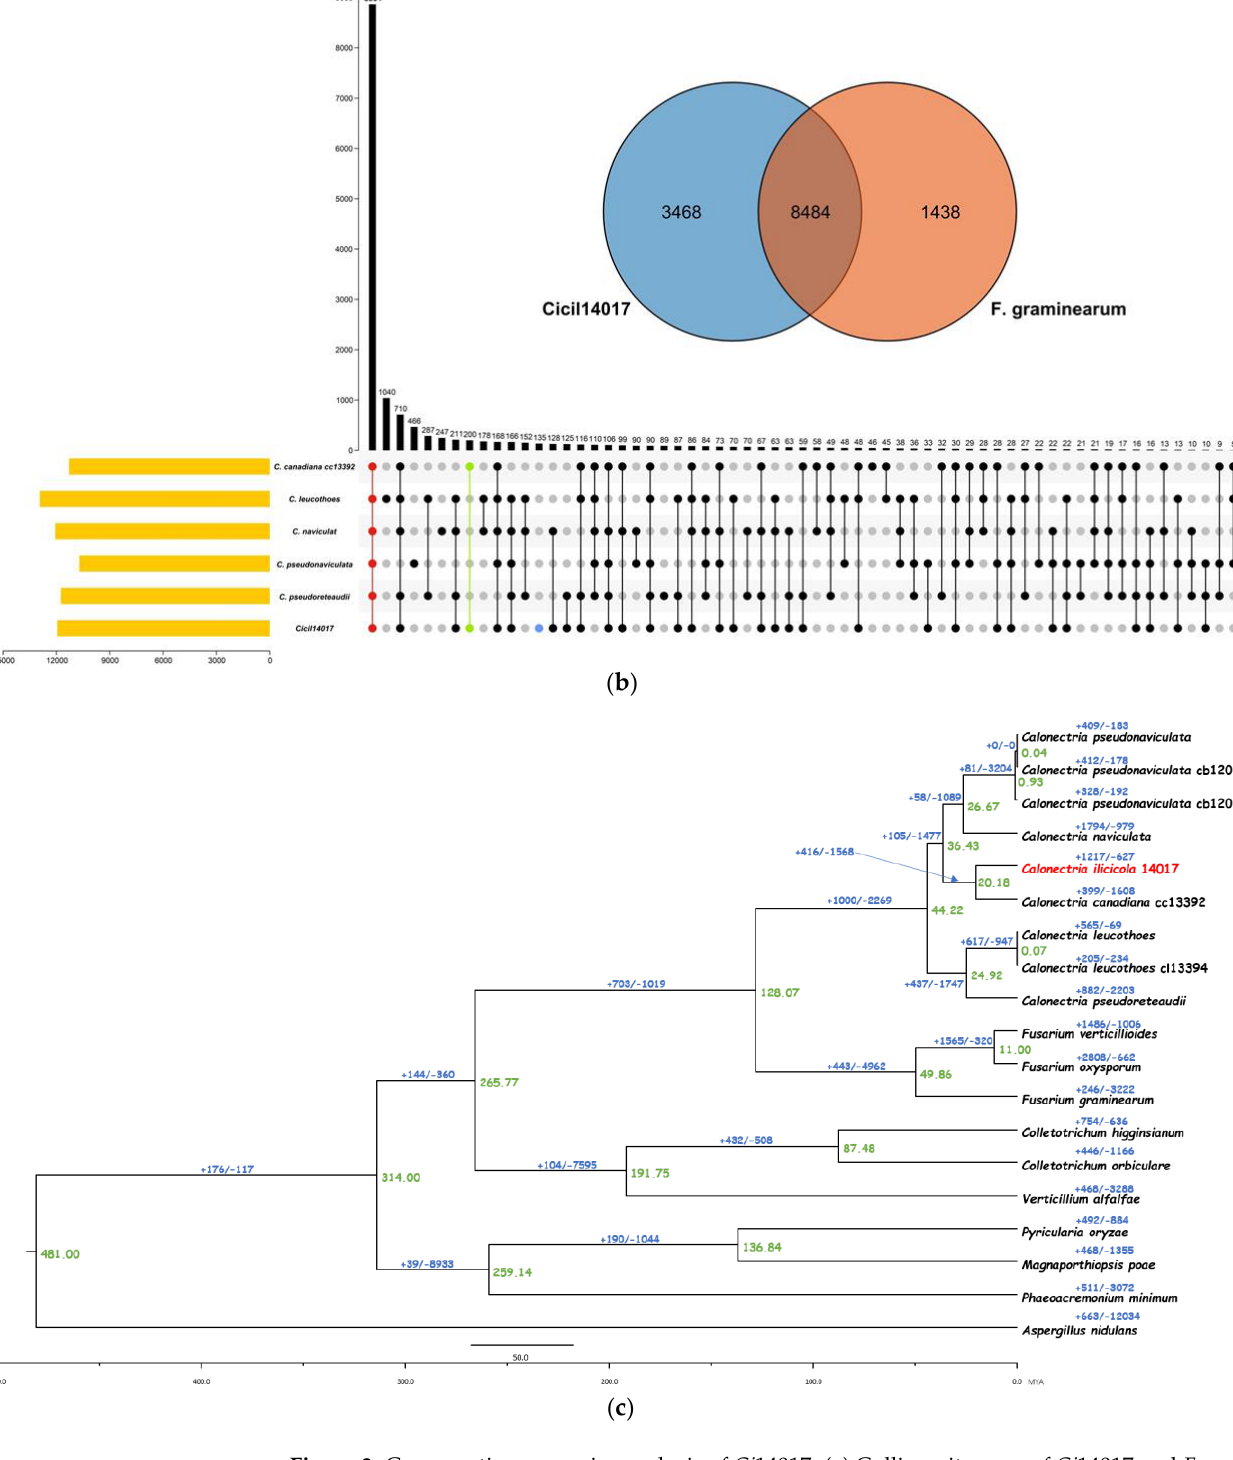
Figure 3. Comparative genomics analysis of Ci 14017. ( a ) Collinearity map of Ci 14017 and Fusarium graminearum genomes. On the top is the F. graminearum genomes, and on the bottom is Ci 14017, with secretory proteins marked in the red line. ( b ) Ci 14017 hyperchronic evolution tree. The green numbers represent fossil ages. The blue numbers represent gene family expansion and contraction. The arrow in the figure points to the branch where the bootstrap support rate is located. ( c ) Venn analysis of gene families of 18 different genomes. The values of the black vertical bar chart indicated the number of homologous genes (including the specific genes of five genomes) in one to five genomes, while the values of the yellow horizontal bar chart indicate the total number of homologous genes in one genome with the other four genomes. The red dots represent the homologous genes of the five genomes. The blue dots represent the specific gene of Ci 14017 and the green dots represent the homologous gene of C. canadiana cc 13392.